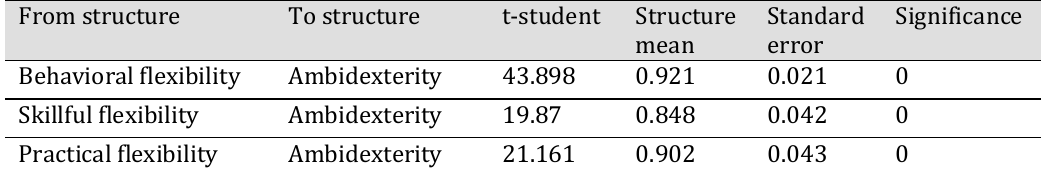
The effects of flexibility components on